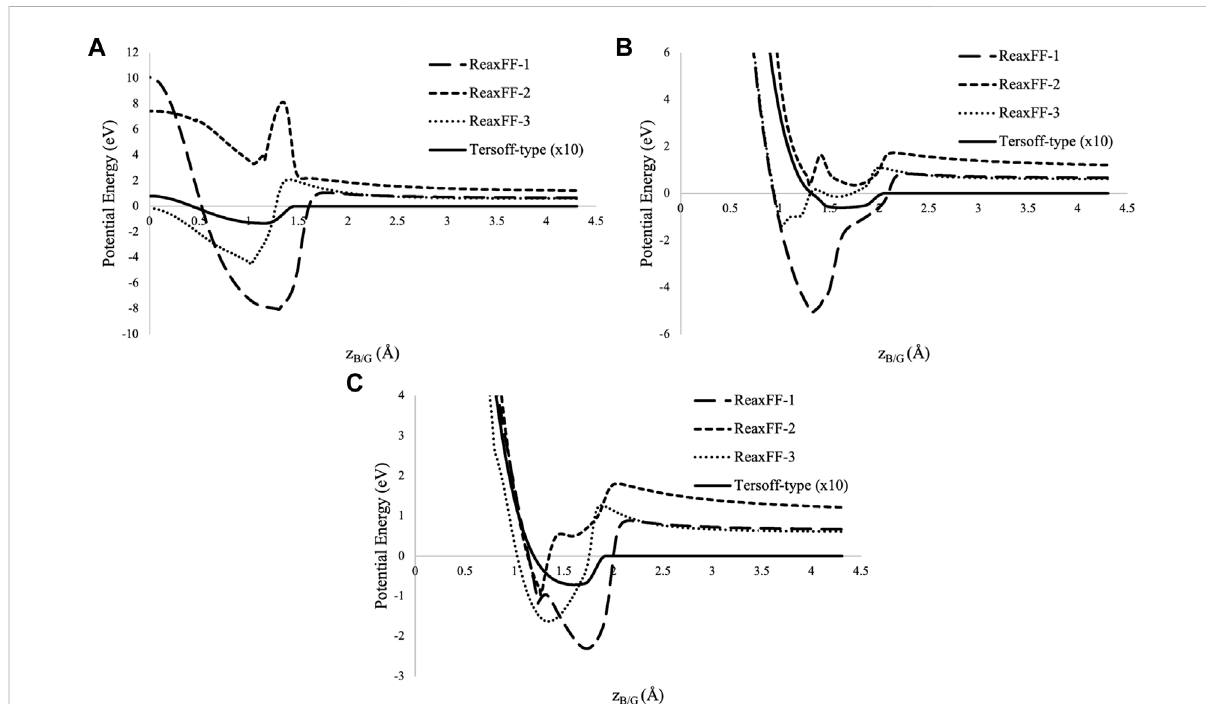
FIGURE 2 Potential energy as a function of boron graphene distance (z B/G ) for the (A) hollow (B) top, and (C) bridge sites. The energy of the Tersoff-type potential [10] is scaled by a factor of 10 to improve visibility of the minimum in comparison to those of the ReaxFF potentials, ReaxFF-1 [11, 16], ReaxFF-2 [12], and ReaxFF-3 [13].